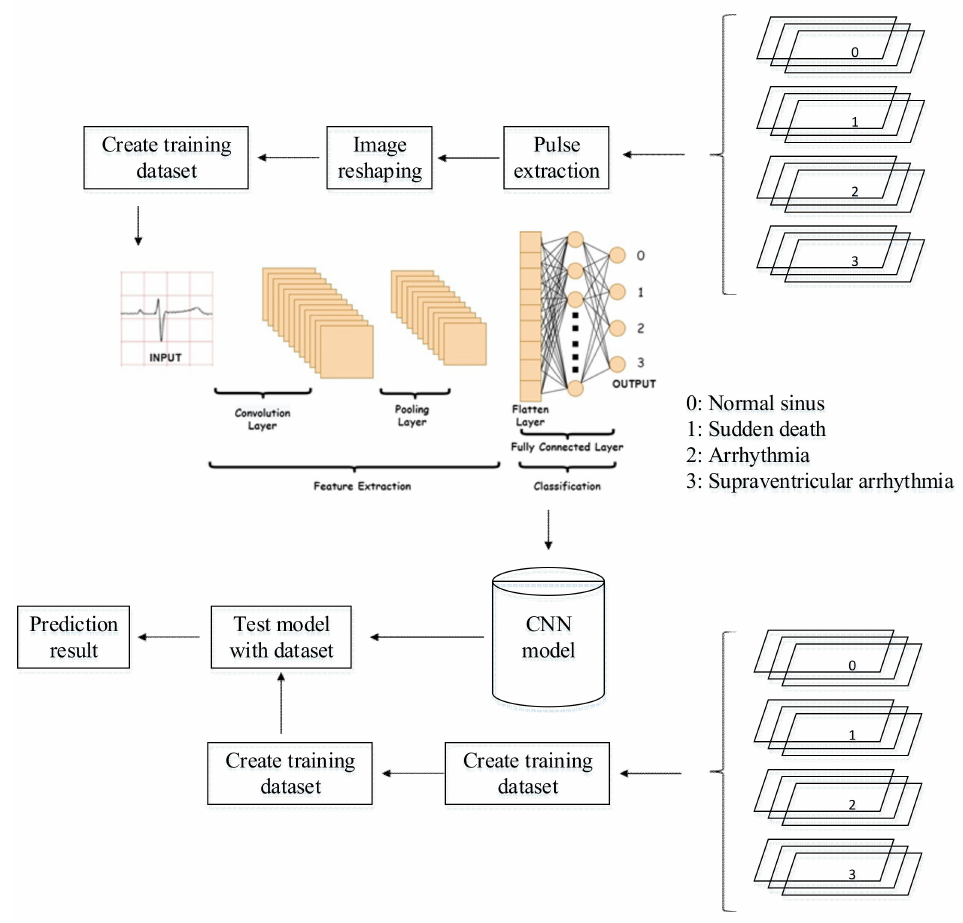
Figure 7. CNN method